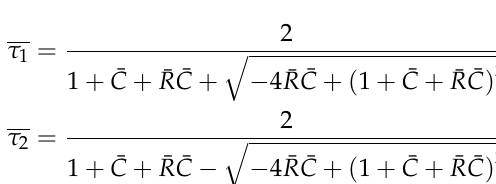
𝑪(cid:3365) =0.1 and 𝑹(cid:3365) = 𝝉 𝟏 and 𝟐 on the pressurization solution at